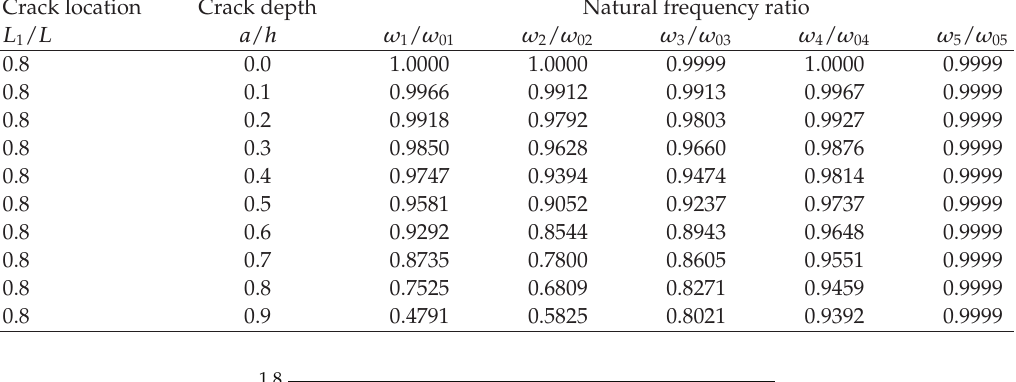
Table 1: Natural frequency ratio with the crack depth at location 0.8.